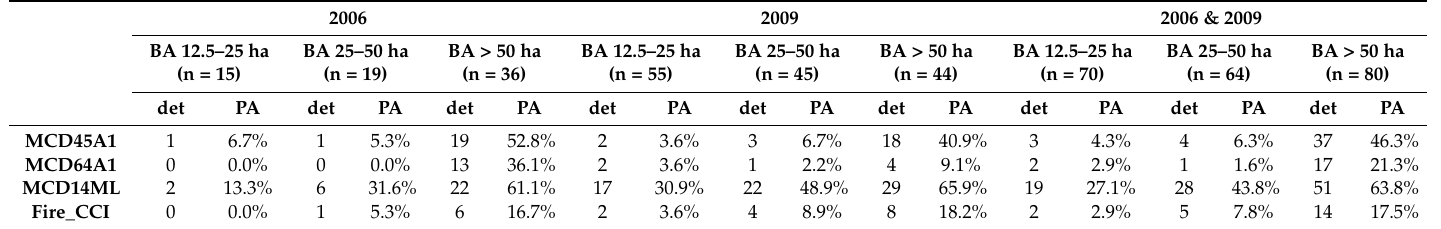
Table 3. Number of fire events correctly detected (det) and producer’s accuracy (PA) of MCD45A1, MCD64A1, MCD14ML, and Fire_CCI products in a control site in northwest Yunnan for the year 2006, 2009, and 2006, and 2009 combined. Three different BA sizes are shown: 12.5 to 25 ha, 25 to 50 ha, and >50 ha.